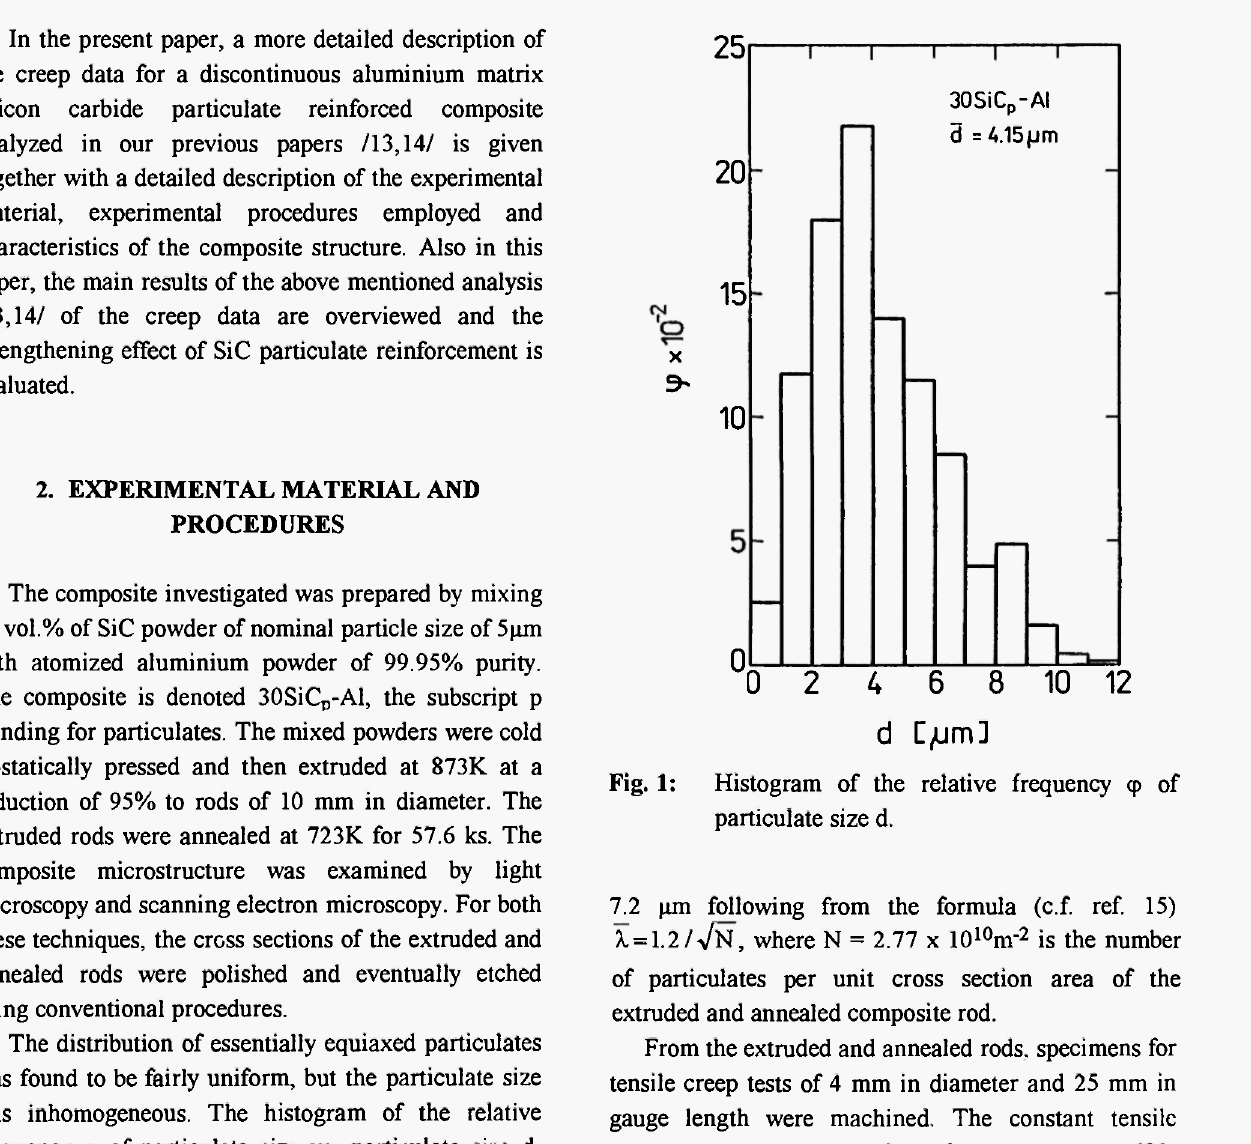
Fig. 1: Histogram of the relative frequency φ of particulate size d.